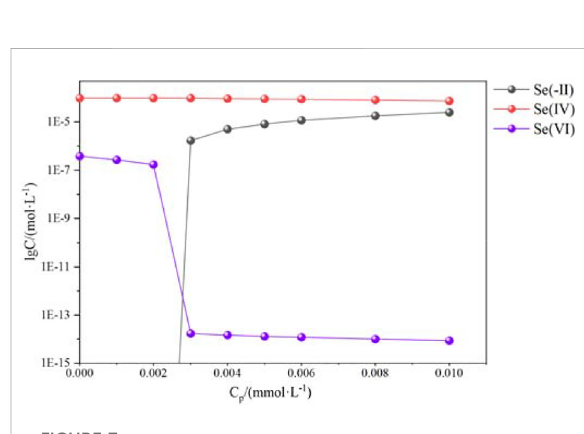
FIGURE 7 Log C of Se(- Ⅱ ), Se( Ⅳ ), and Se( Ⅳ ) as a function of the pyrite concentration.